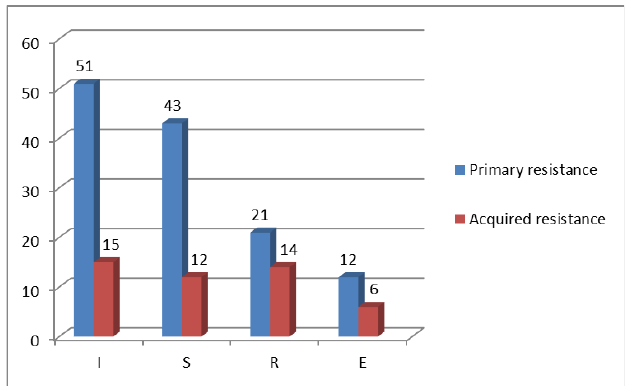
Figure 1. Total resistance to I, S, R, and E in M. tuberculosis strains isolated from new (primary re- sistance) and previously treated patients (acquired resistance), 2020.